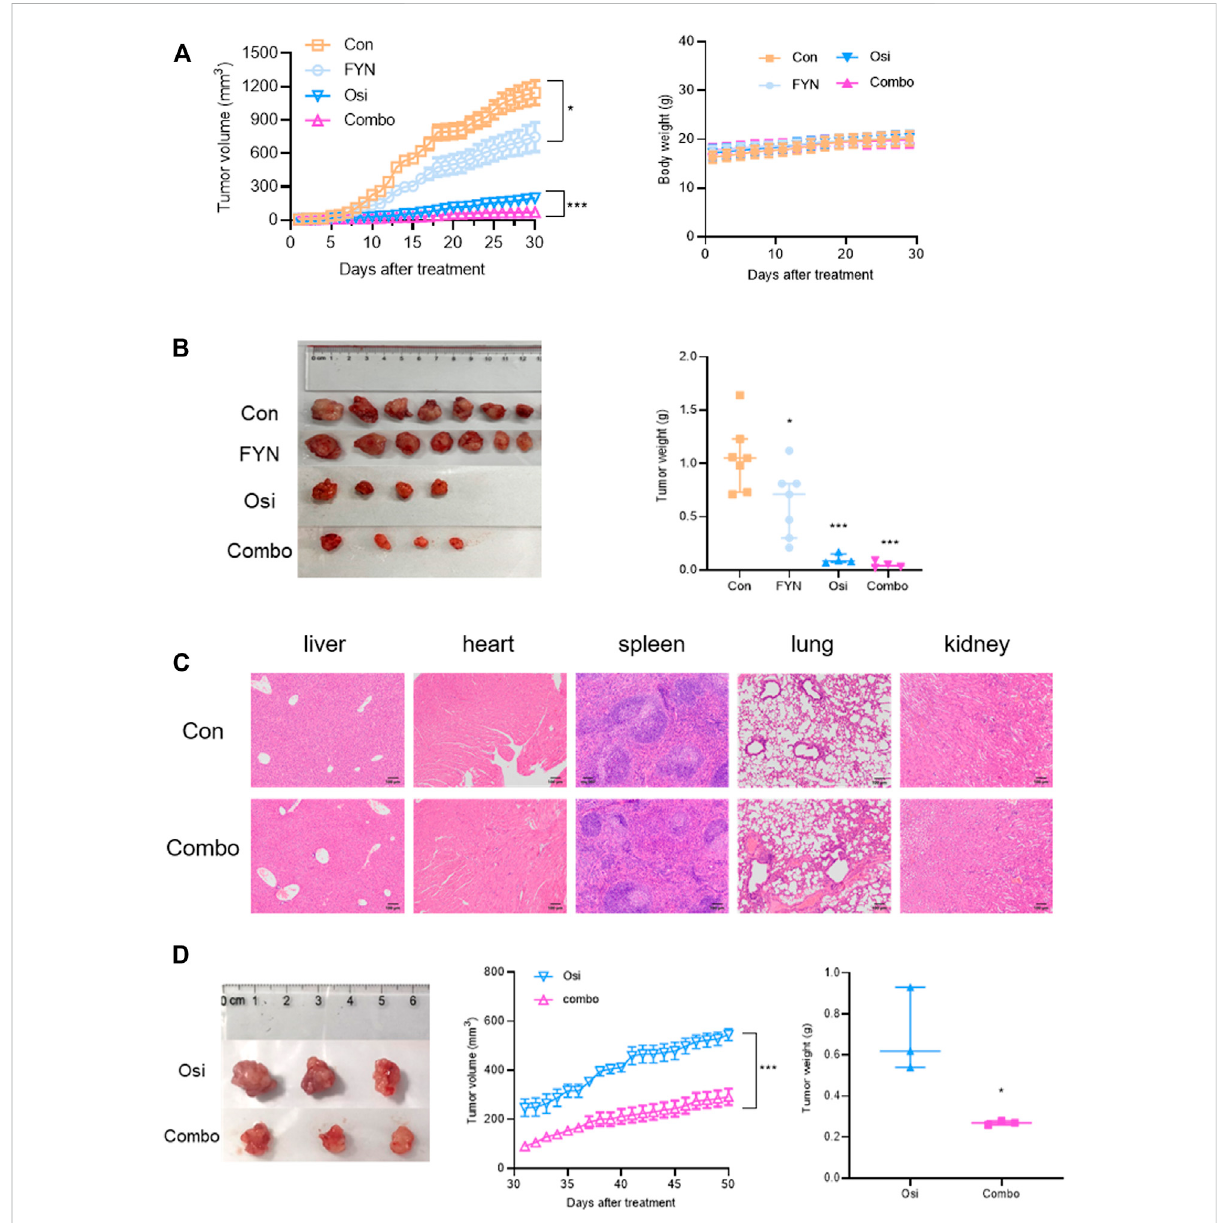
FIGURE 6 FYN combined with osimertinib suppressed tumor growth in mouse xenograft models of lung adenocarcinoma. (A) Tumor growth curve and body weight of subcutaneous HCC827OR xenografts ( n = 7). (B) Mice in the control group ( n = 7), FYN group ( n = 7), osimertinib group ( n = 4) and combination group ( n = 4) were anaesthetized to determine tumor volumes and weights 30 days after treatment. (C) Organs of mice in the control group and the combination group were harvested 30 days after treatment and stained with hematoxylin and eosin. (D) Tumor growth